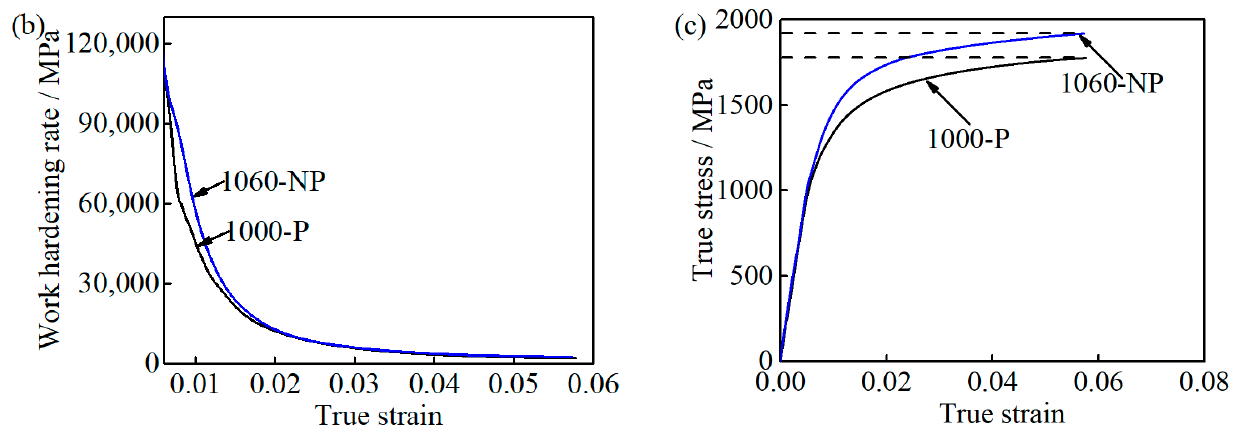
Figure 11. Comparison between the 1000-P and 1060-NP: ( a ) engineering stress-strain curves and elongation; ( b ) work hardening curves; and ( c ) the true stress-strain curves.